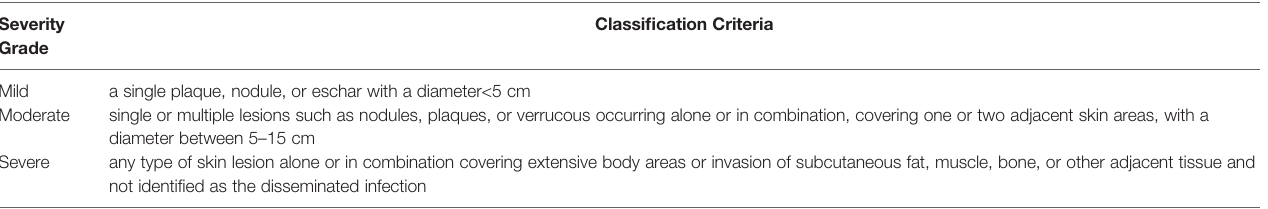
Classi fi cation Criteria